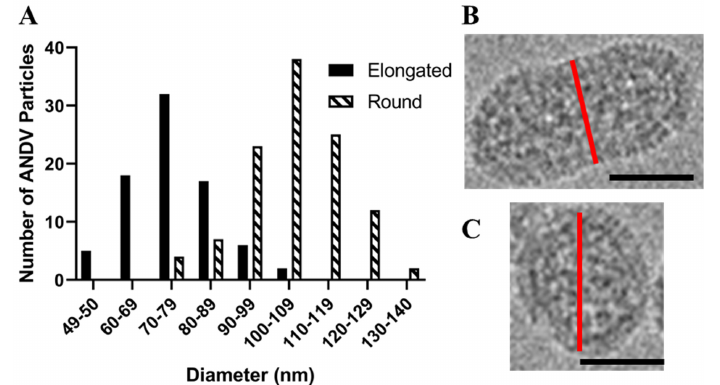
Figure 4. Histogram of ANDV diameters for round and tubular particles. ( A ) The diameter of 112 round and 80 tubular ANDV particles in cryo-EM images were measured and graphed in the above histogram. Panels B and C illustrate the axis (red line) by which diameters of elongated versus round particles were measured. Scale bars are 50 nm. Table 1. Proportions of distinct morphologies noted in New and Old World hantaviruses. Species Round (%) Tubular (%) Irregular (%) HTNV (our study) 65 30 Old World